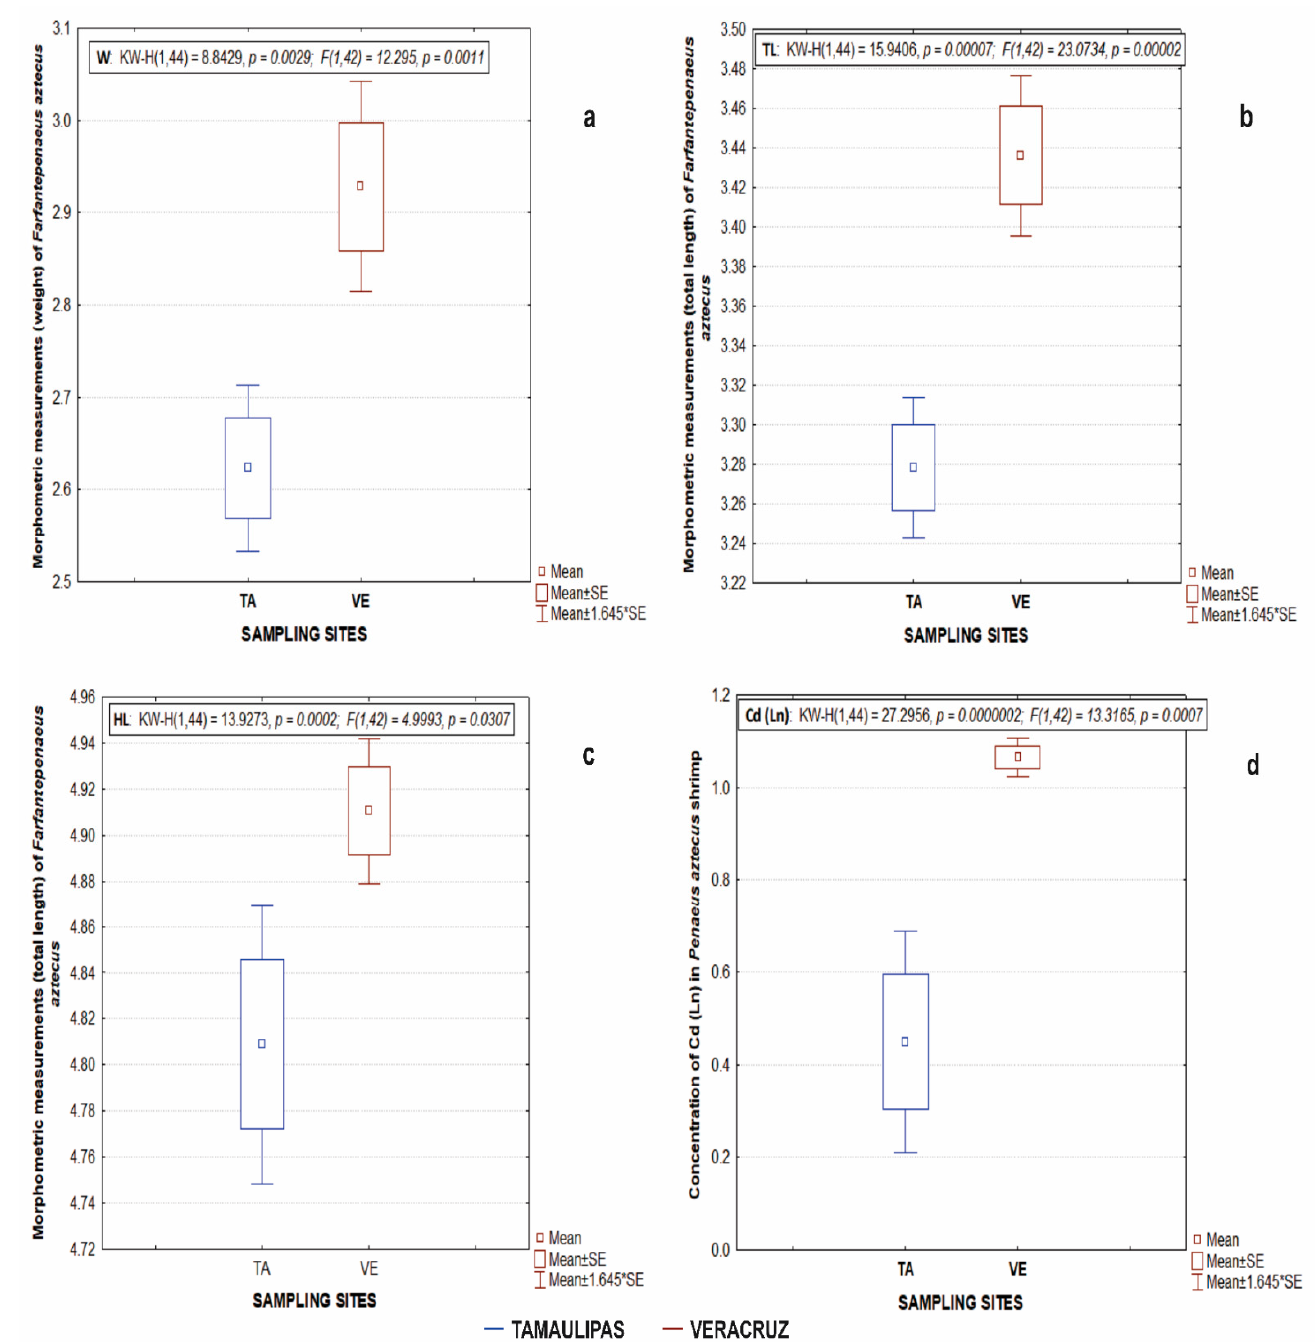
Figure 2. Morphometric measurements of Penaeus aztecus , weight ( a ), total length ( b ), head length ( c ) and concentration of Cd ( d ) in the study areas of Veracruz (VE) and Tamaulipas (TA), Mexico.